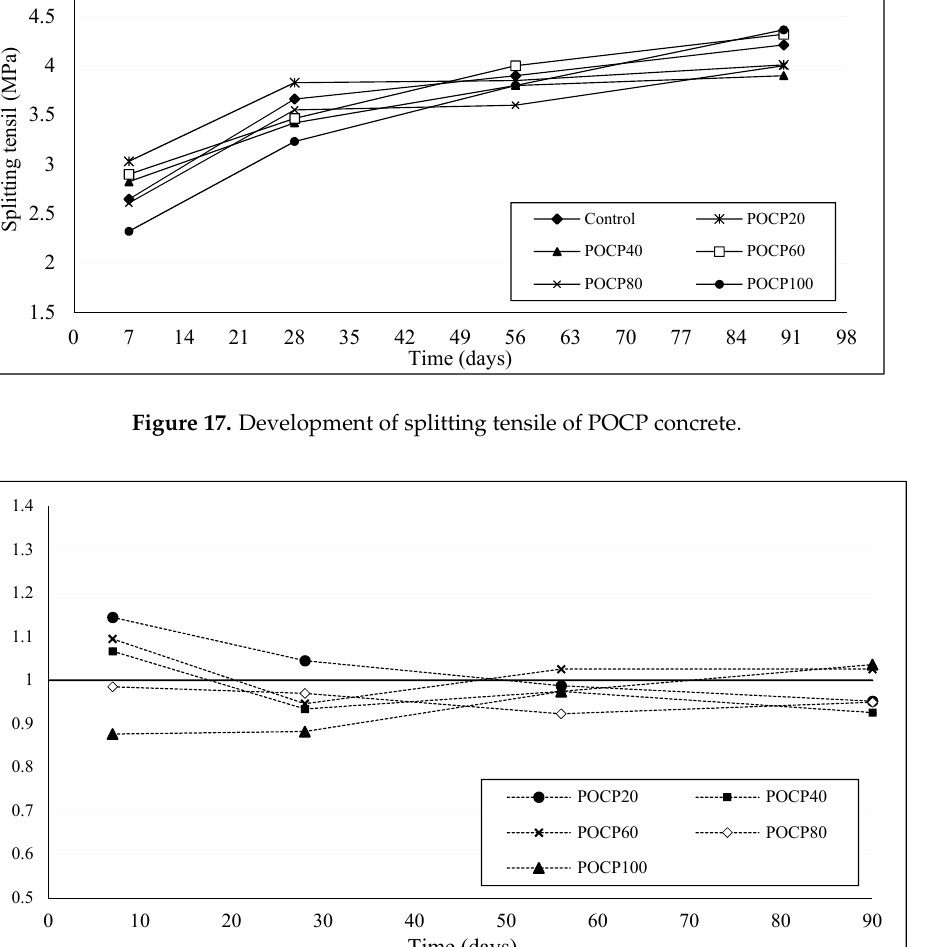
Figure 18. Relative splitting tensile strength of POCP concrete.